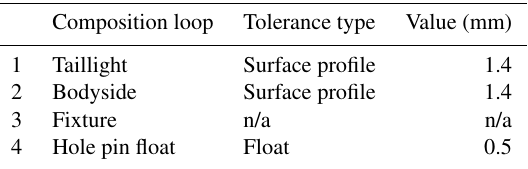
Figure 7. Gap DTS between taillight and bodyside. Table 1. Tolerance of the composition